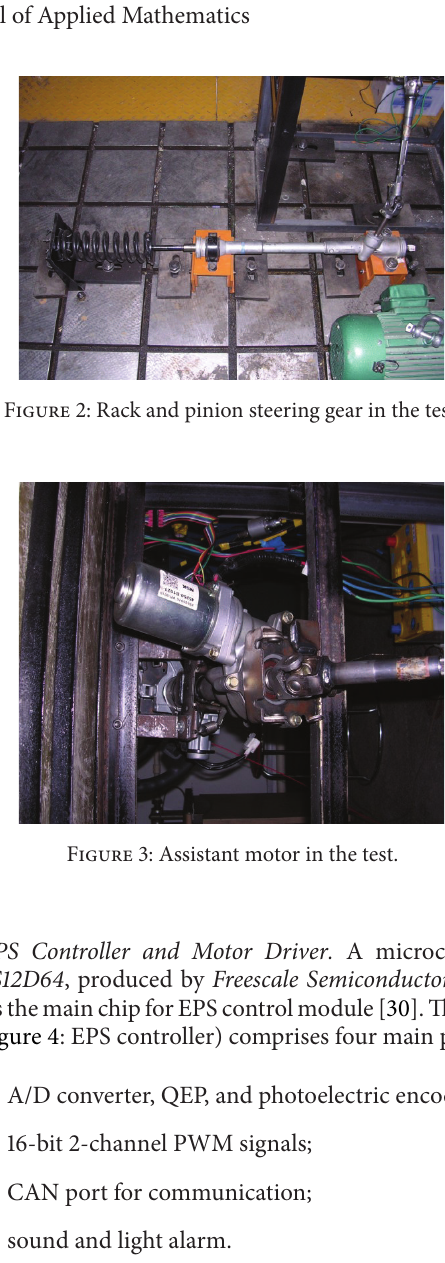
Figure 6: Monitor program on PC in the test.